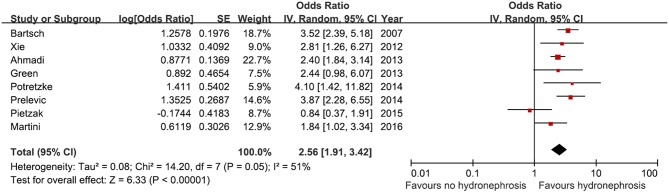
Forest plot and meta-analysis of advances pathological stage after radical cystectomy according to preoperative hydronephrosis. SE, standard error; IV, inverse variance; CI, confidence interval; df, degrees of freedom.